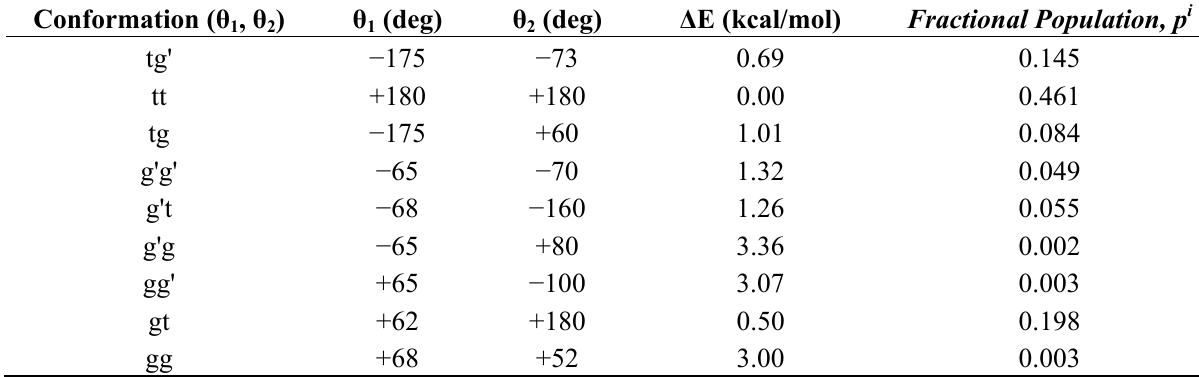
, θ potential energy 1 2